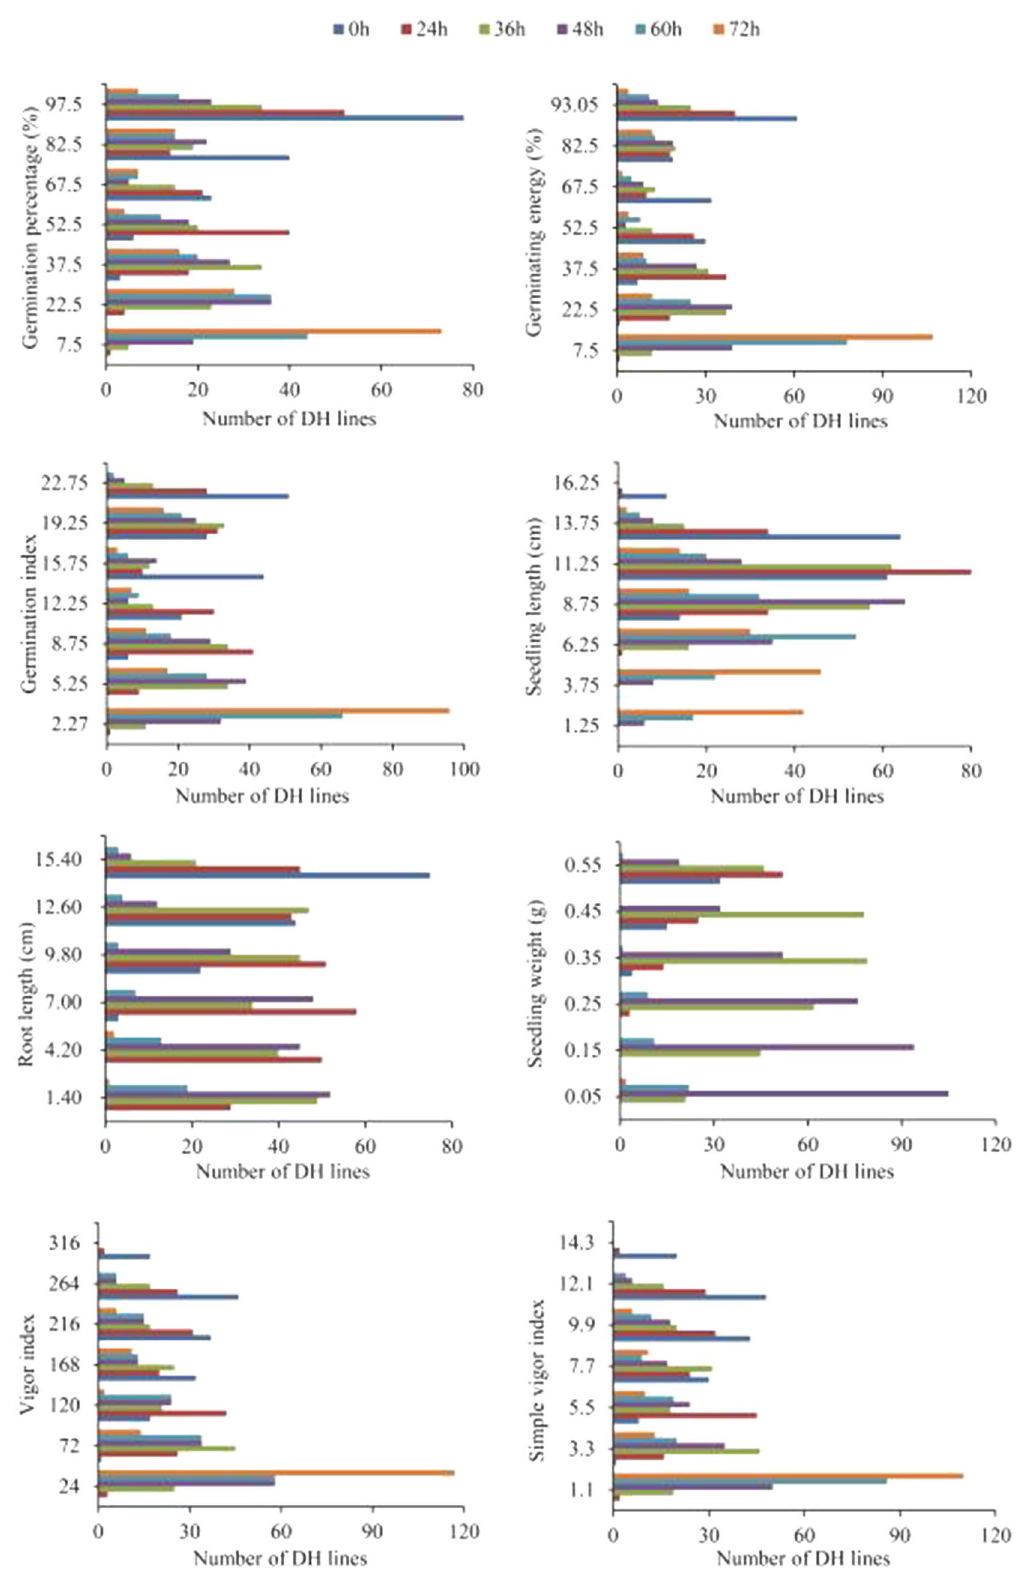
Figure 1. Frequency distribution of seed vigor-related traits in wheat DH